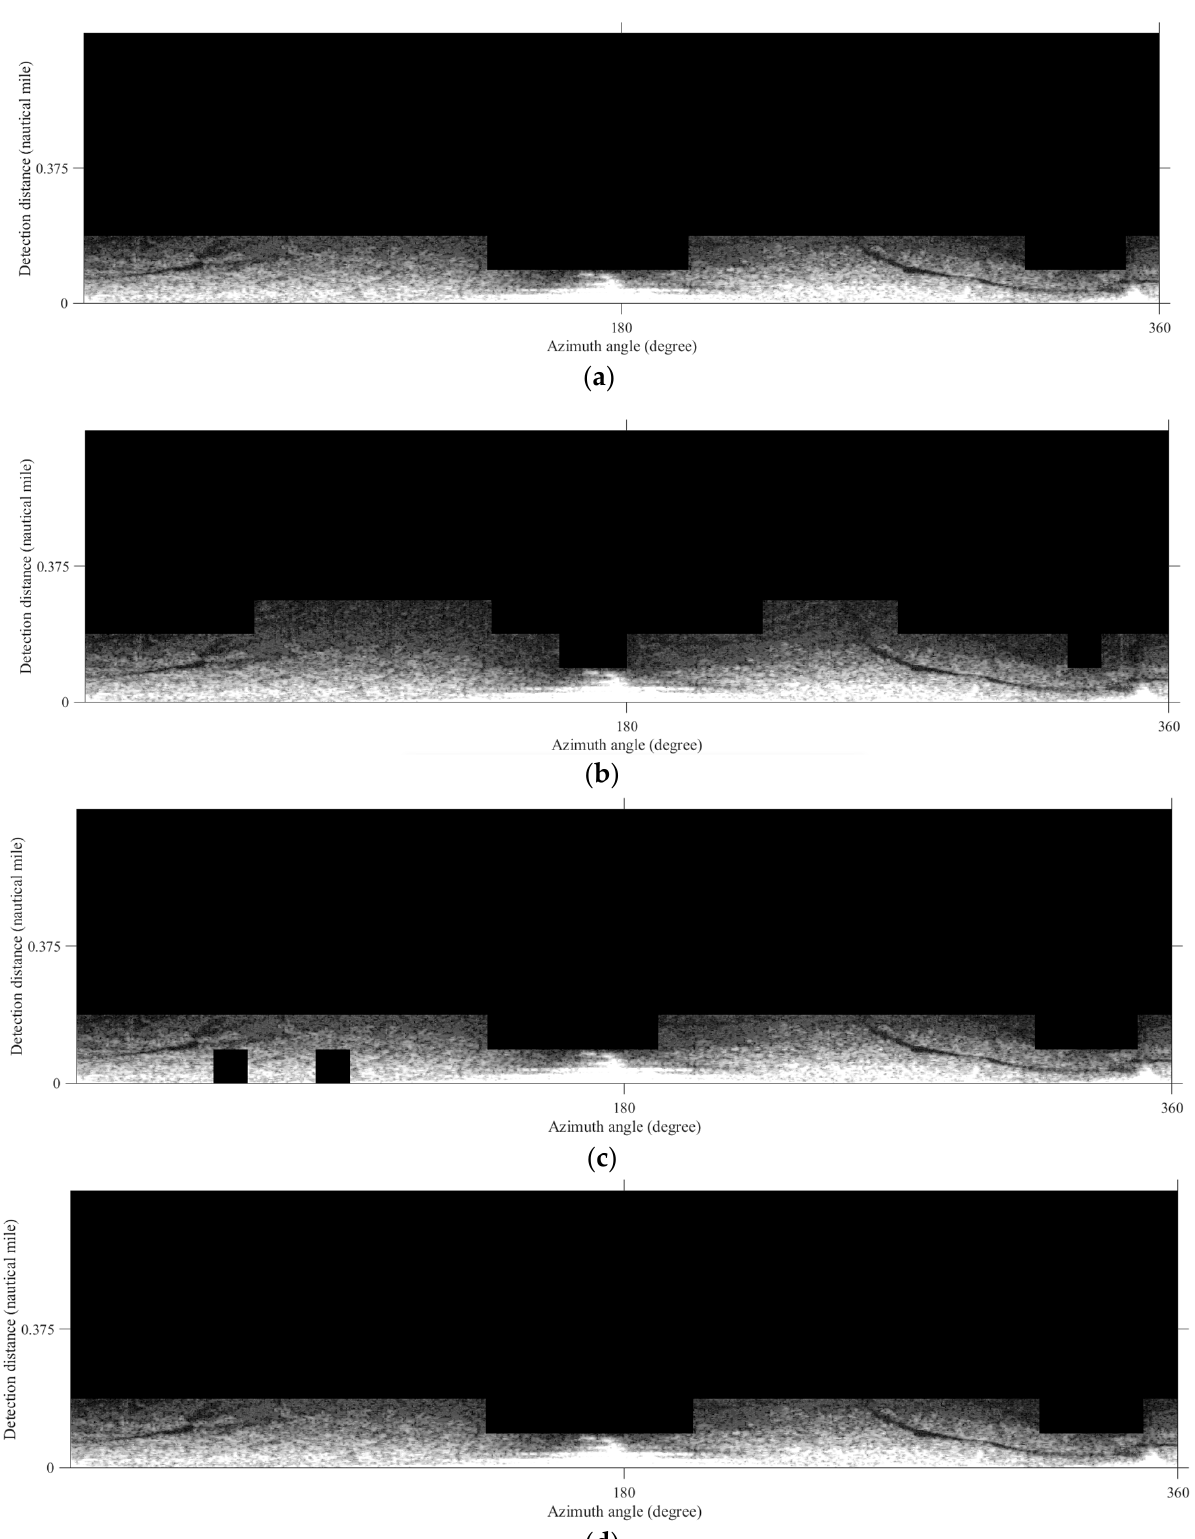
Figure 9. The valid wave region: ( a ) BP neural network; ( b ) K-Nearest Neighbor; ( c ) Decision Tree; ( d ) Random Forest. Table 4. Comparison of computing time and classification accuracy.